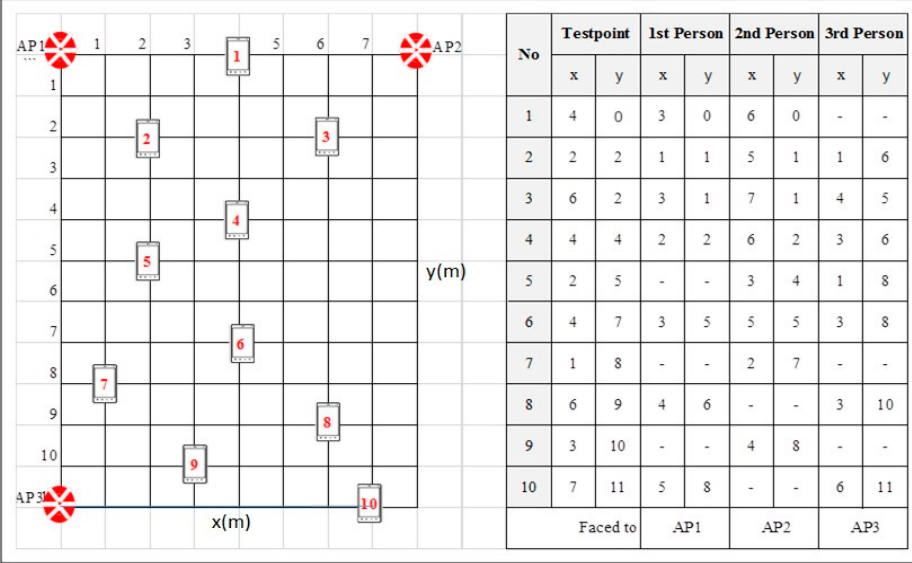
Figure5. People allocation for each testing point. Figure 5. People allocation for each testing point.